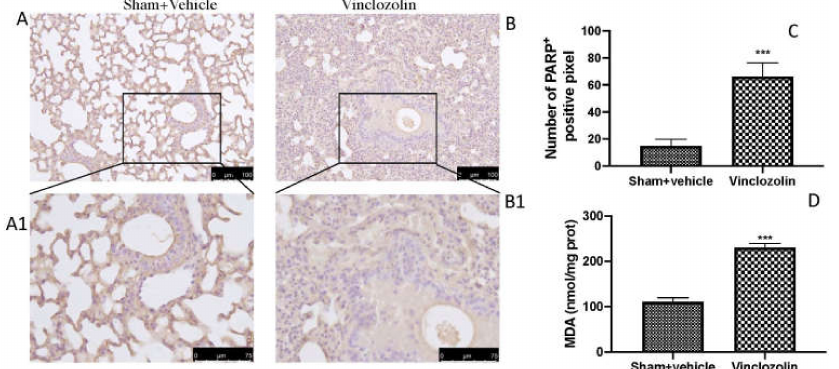
Figure 6. Exposure to vinclozolin induced DNA damage and lipid peroxidation. Immunohisto- chemistry localization of PARP for sham ( A , A1 ) and for vinclozolin-treated ( B , B1 ) animals; score ( C ); MDA levels ( D ). Vinclozolin induced an increase in PARP expression, as well as in lipid peroxidation. Values are the means ± SD of 6 mice per group. Images shown are representative of the results obtained. *** p < 0.001 vs.